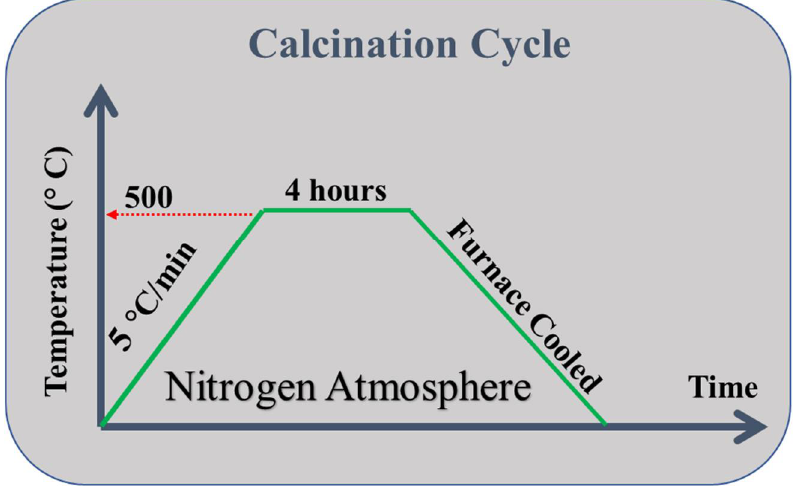
Figure 1. Calcination cycle explaining calcination of dried powder at 500 °C for 4 h under nitrogen atmosphere.